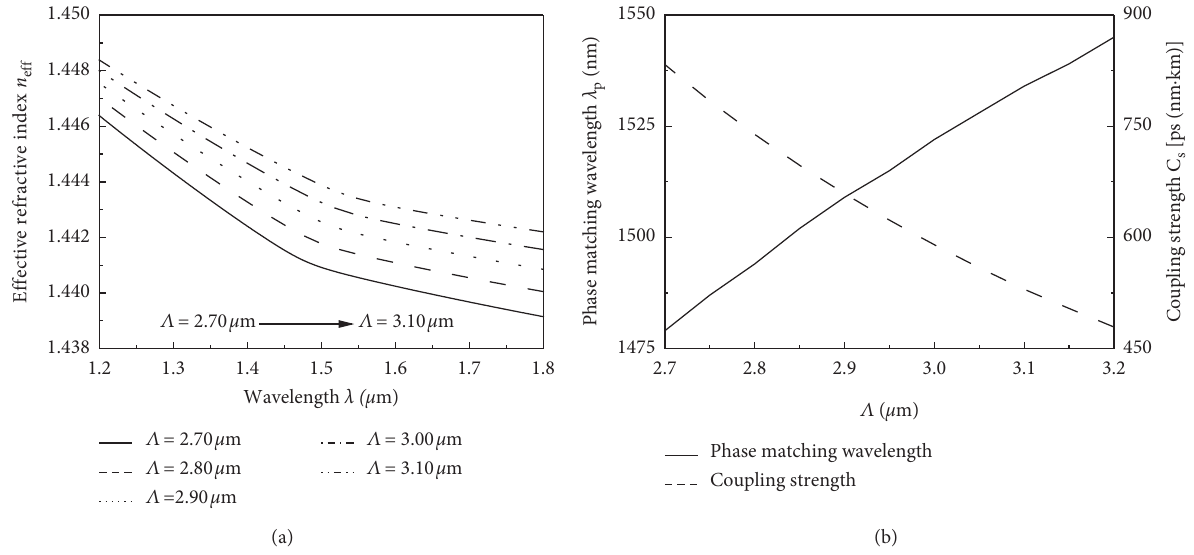
Figure 7: Variation of the effective refractive index of the fundamental supermodel with wavelength when ∧ is changed (a) and λp and the coupling strength with ∧